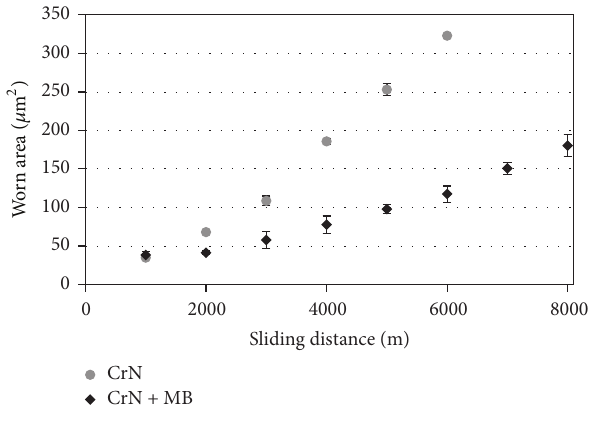
Figure 8: Evolution of the wear scare